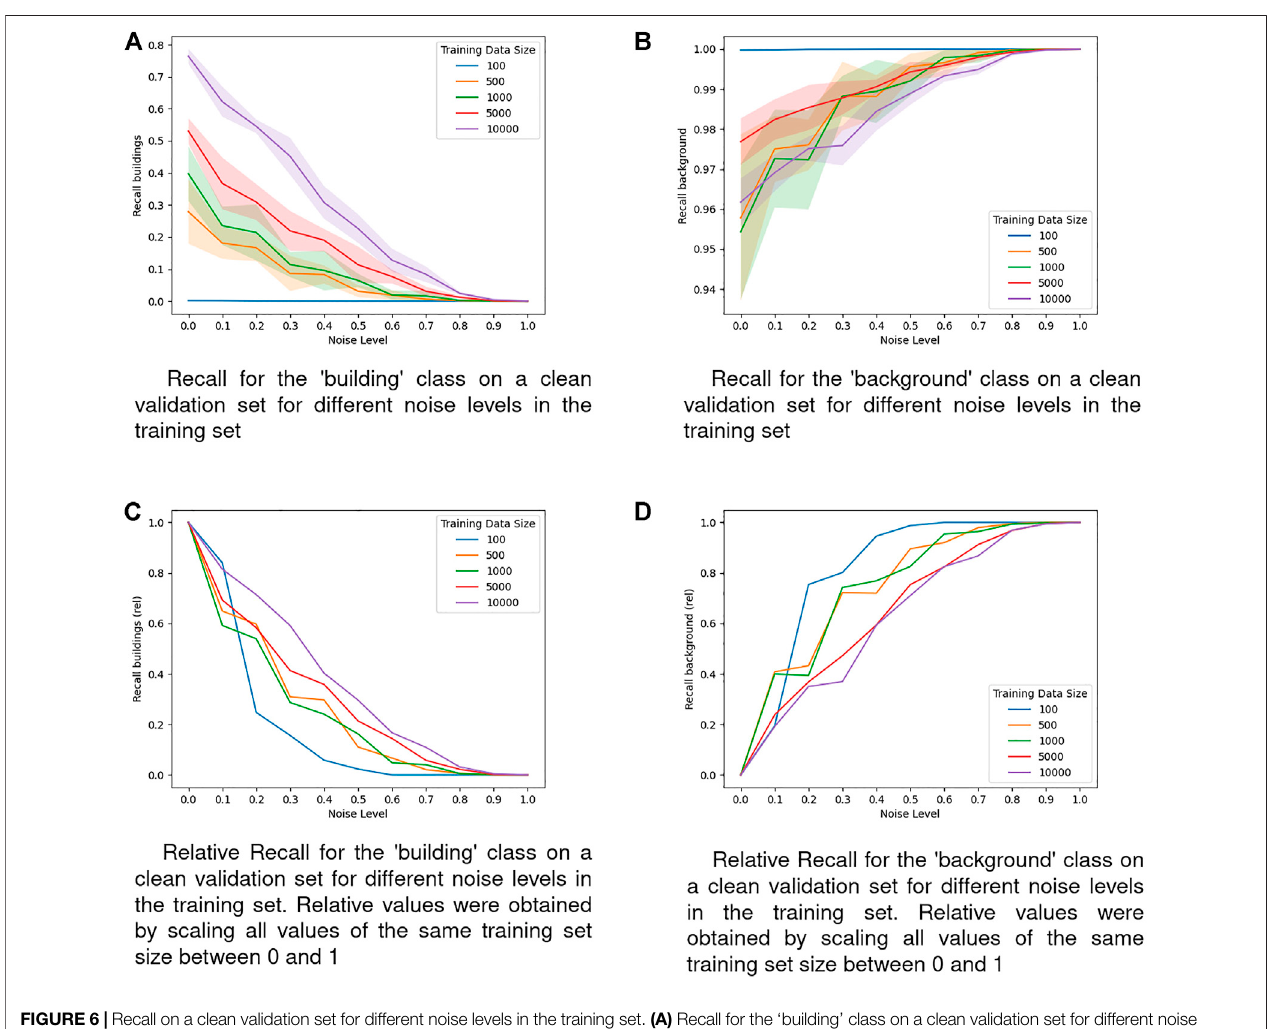
FIGURE 6 | Recall on a clean validation set for different noise levels in the training set. (A) Recall for the ‘ building ’ class on a clean validation set for different noise levelsinthetrainingset. (B) Recallforthe ‘ background ’ classonacleanvalidationsetfordifferentnoiselevelsinthetrainingset. (C) RelativeRecallforthe ‘ building ’ class on aclean validationsetfordifferentnoiselevels inthetrainingset.Relativesvalues wereobtained byscallingallvaluesofthesametrainingset sizebetween0and 1. (D) Relative Recall forthe ‘ background ’ classon aclean validation set fordifferentnoiselevels inthe trainingset. Relativesvalueswereobtainedbyscallingall valuesof the same training set size between 0 and